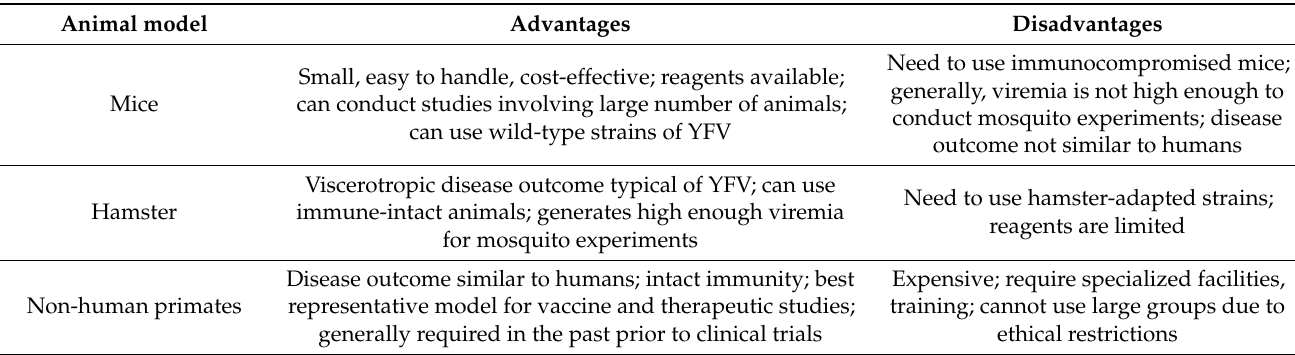
Table 3. Advantages and disadvantage of animal models of